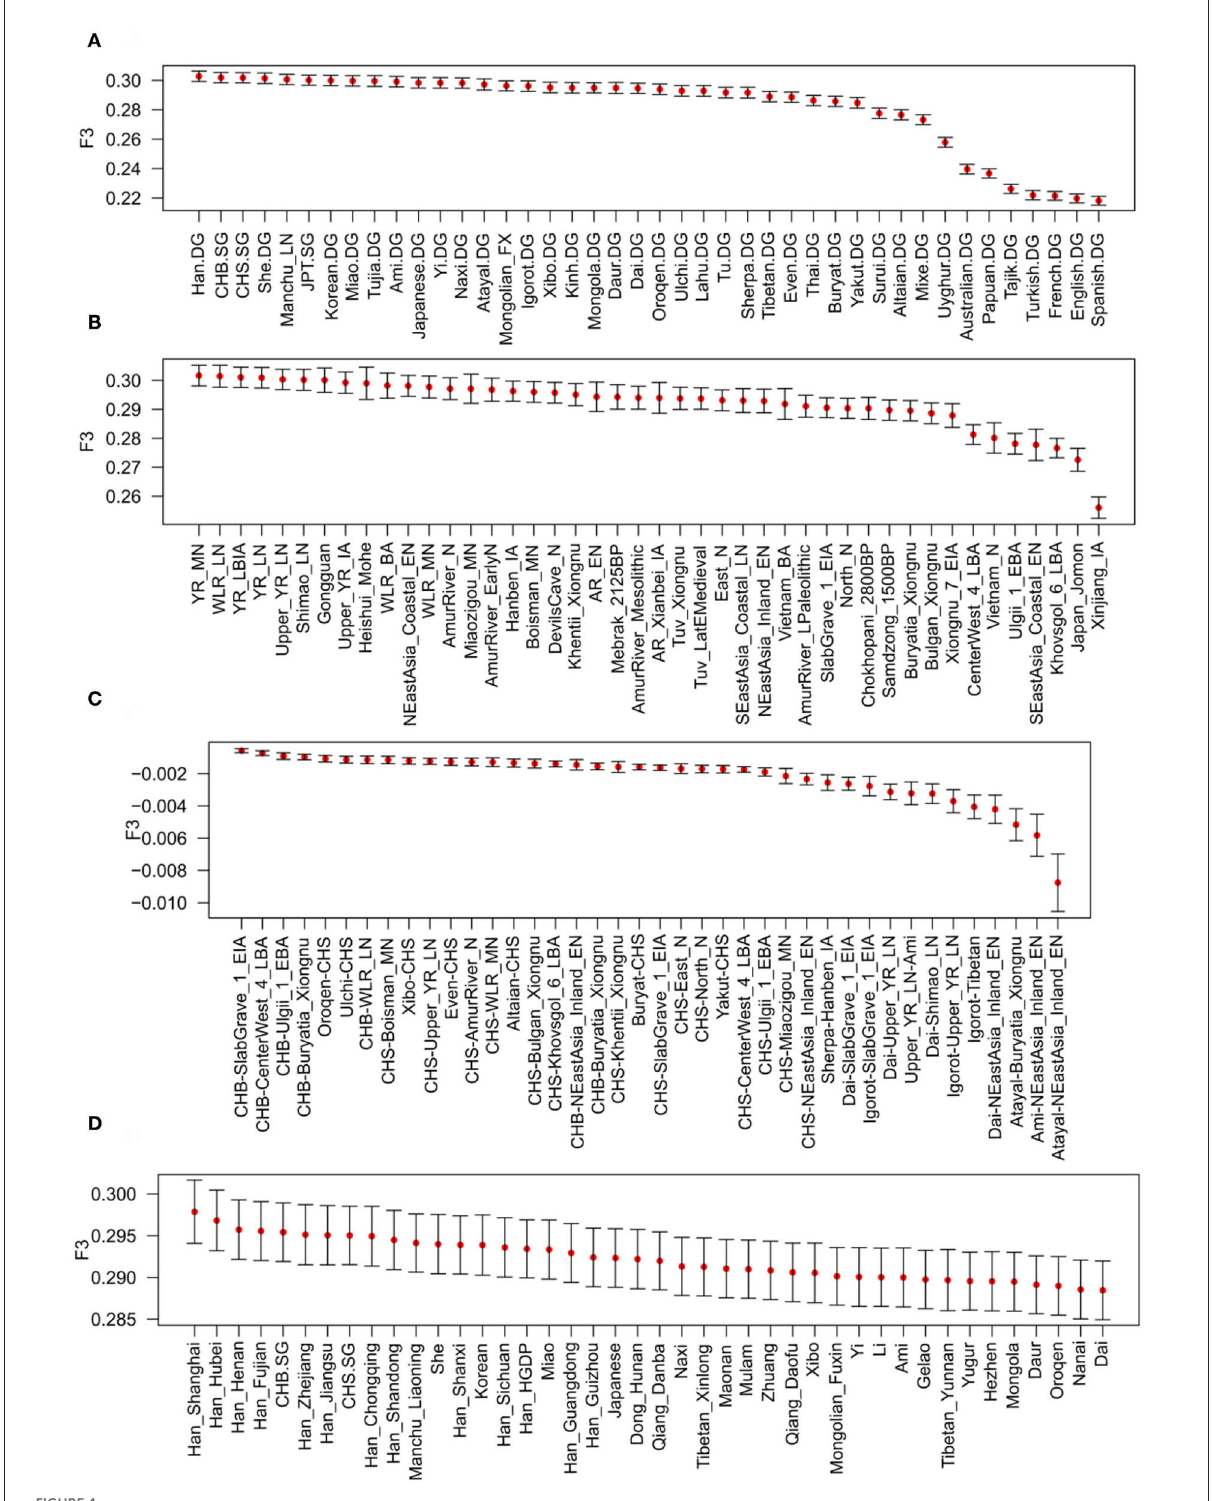
FIGURE4 Shared genetic drift and genetic affinity measured via f 3 -statistics analysis. (A) Outgroup- f 3 (Han_Liaoning, Modern population; Mbuti) based on the “Merged-1240K” dataset; (B) outgroup- f 3 (Han_Liaoning, Ancient population; Mbuti) based on the “Merged-1240K” dataset; (C) admixture- f 3 (Modern/Ancient population1, Modern/Ancient population2; Han_Liaoning) based on the “Merged-1240K” dataset; (D) outgroup- f 3 (Han_Liaoning, Modern population; Mbuti) based on the “Merged-HO”